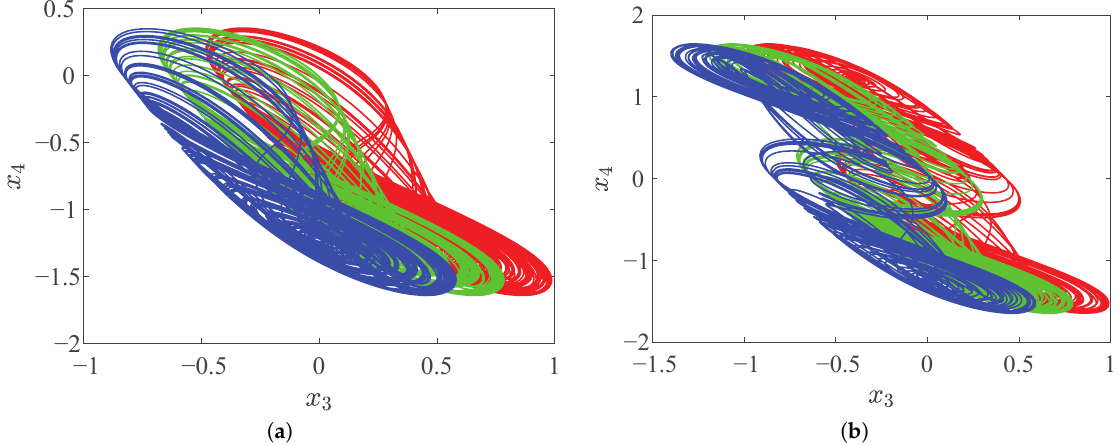
Figure 13. Offset boosting ( ¯ p = 0 (red), ¯ p = 0.2 (green), ¯ p = 0.4 (blue)) with change in fractional-order q . ( a ) q = 0.85, ( b ) q = 0.90.